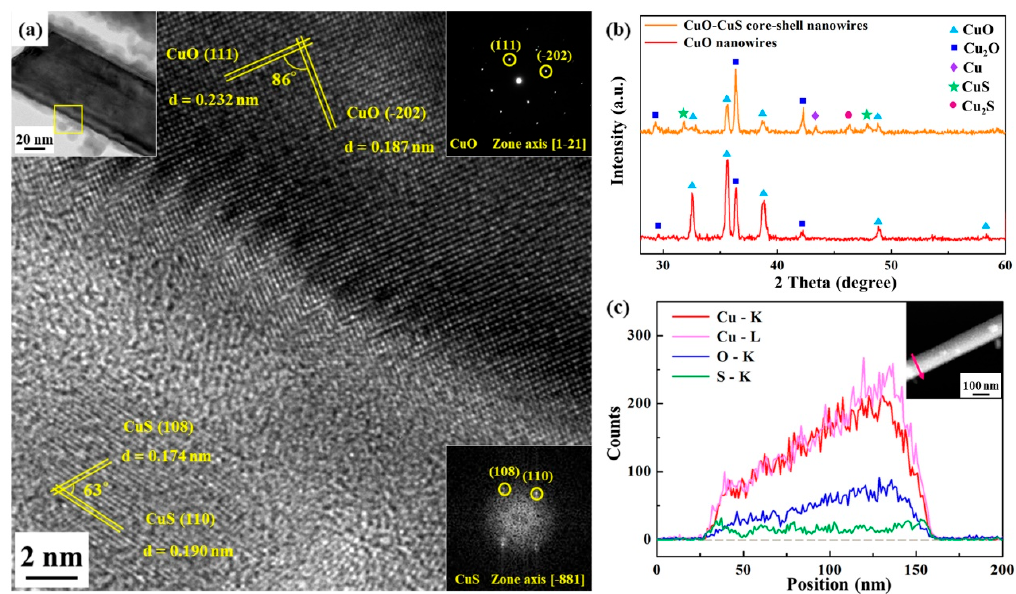
Figure 2. FE-SEM images of CuO nanowires under sulfurization process at different temperatures ( a ) 200 °C, ( b ) 250 °C, ( c ) 300 °C.